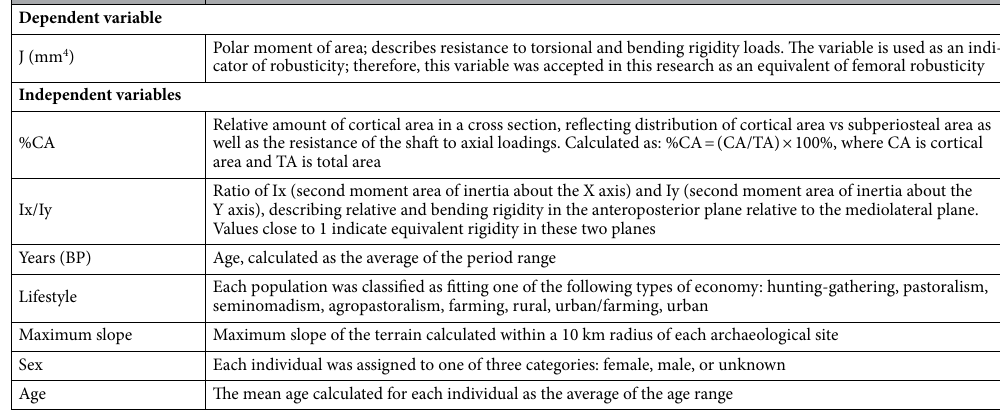
Table 3. Description of variables used in the